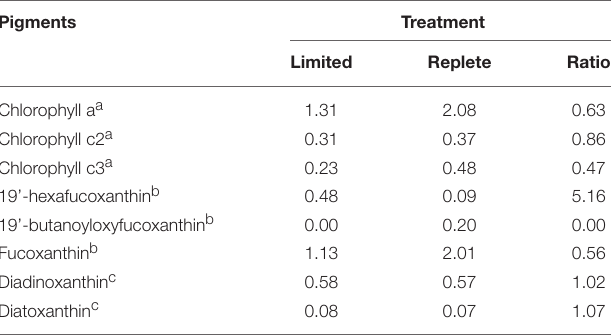
TABLE 1 | Steady state phytoplankton pigment composition in non-infected Fe-limited (first column) and Fe-replete (second column) P. globosa cultures.